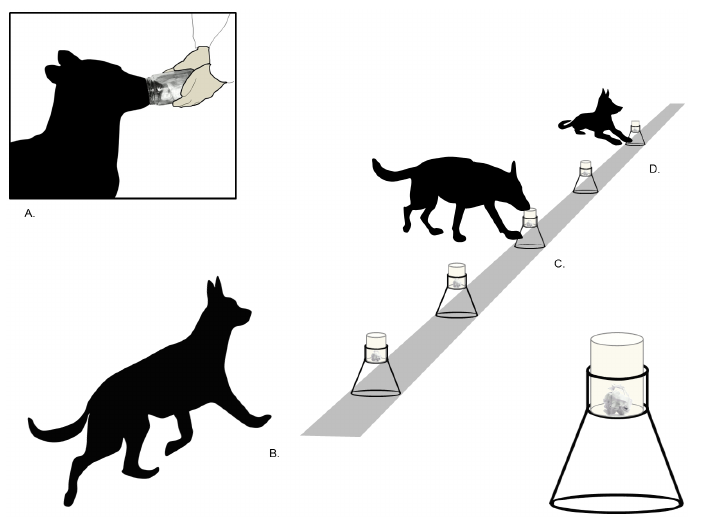
Fig 1. Four positions of a trained dog during the human scent line-up task. 1A: the dog sampled the target scent inside the jar. 1B: the dog was then required to walk the line from the starting point. 1C: the dog sniffed in all of the jars along the line. 1D: when an odour in the line matched the target sample, the dog lay down in front of the corresponding jar. An enlargement of the drawing representing the tripod we use in our procedure is represented at the bottom of the